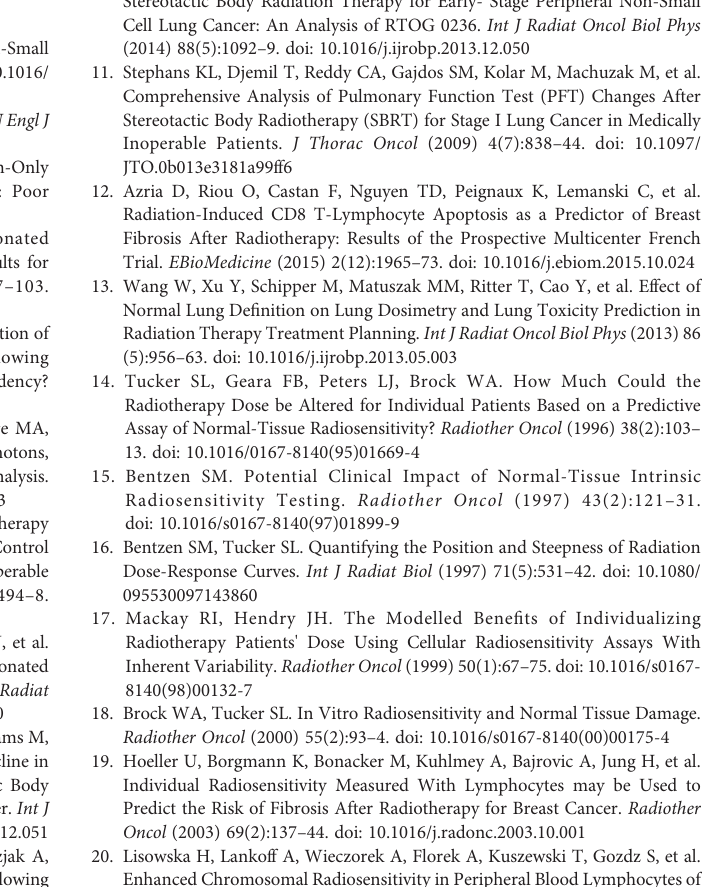
Supplementary Figure 1 | Survival data after SBRT of the lung cancer patients Survival outcome data of the lung cancer patients of our study after stereotactic radiotherapy: (A) Local relapse free survival (B) Regional relapse free survival (C) Distant metastasis free survival (D) Survival without new treatment (E) Lung cancer speci fi c survival (F) Overall survival. Supplementary Figure 2 | Chromosome aberrations of the lymphocytes after in vitro irradiation in SBRT patients and healthy volunteers. The mean of chromosome frequencies (± SE) after 3 and 6 Gy in vitro irradiation of healthy controls and lung cancer patients are shown at different time